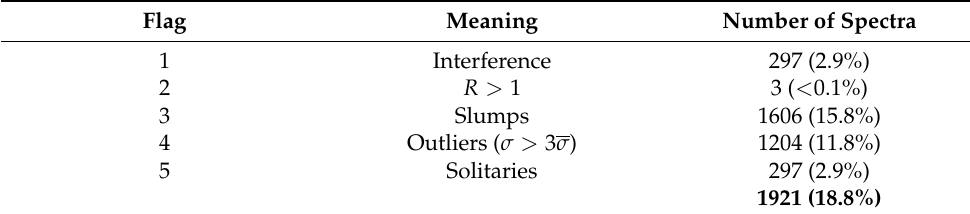
Table A1. Flags that we assigned to spectra picked from the HySpex images for subsequent automated cleaning. Since some spectra were flagged multiple times, the sum of the spectra per flag exceeds the sum of all flagged spectra, which is shown below in bold. Flag Meaning Number of